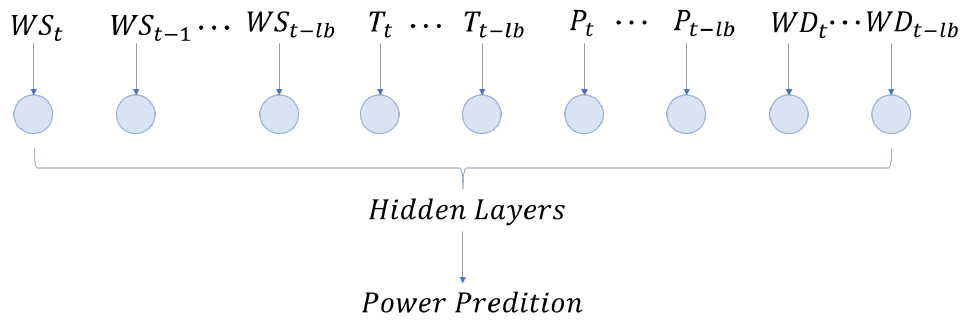
Figure 4. Scheme of the input layer of the ANN. WS stands for wind speed, T for temperature, P for pressure and WD for wind direction. The subscript t is the current time, and each value is lagged until reaching the time corresponding to the subscript t − lb ; where lb stands for the look-back